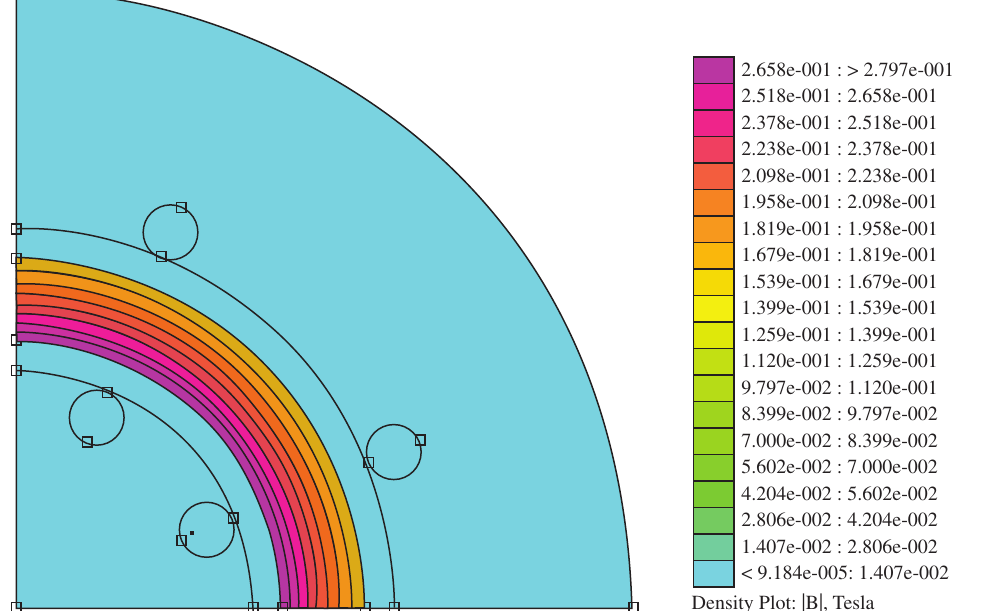
Density Plot: |B|, Tesla